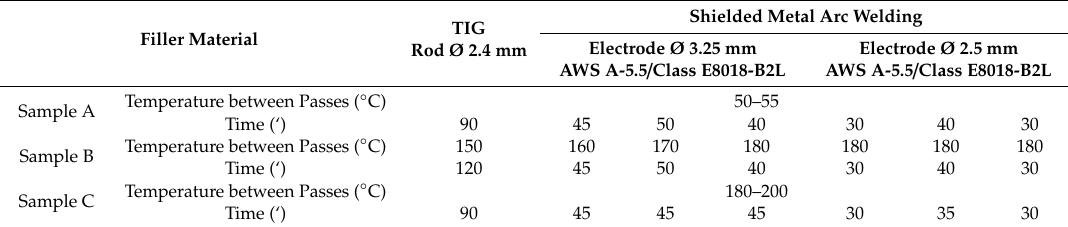
Table 2. Welding